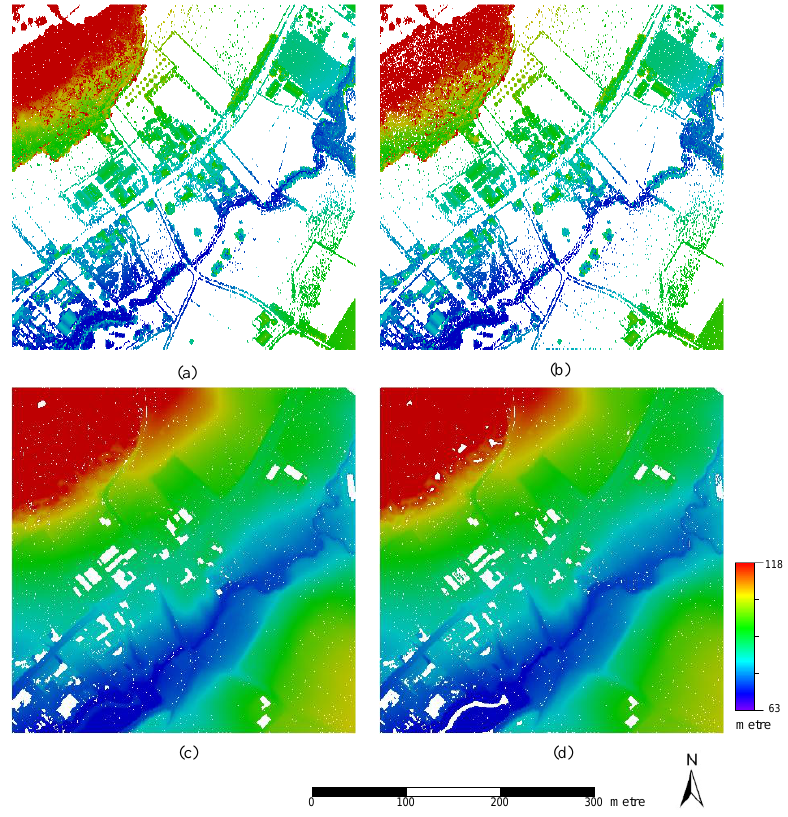
Figure 17. Results of the proposed method filtering AHN Test Site 1: ( a ) true non-ground points; ( b ) non-ground points derived by this filter; ( c ) true ground points; and ( d ) ground points derived by this filter.